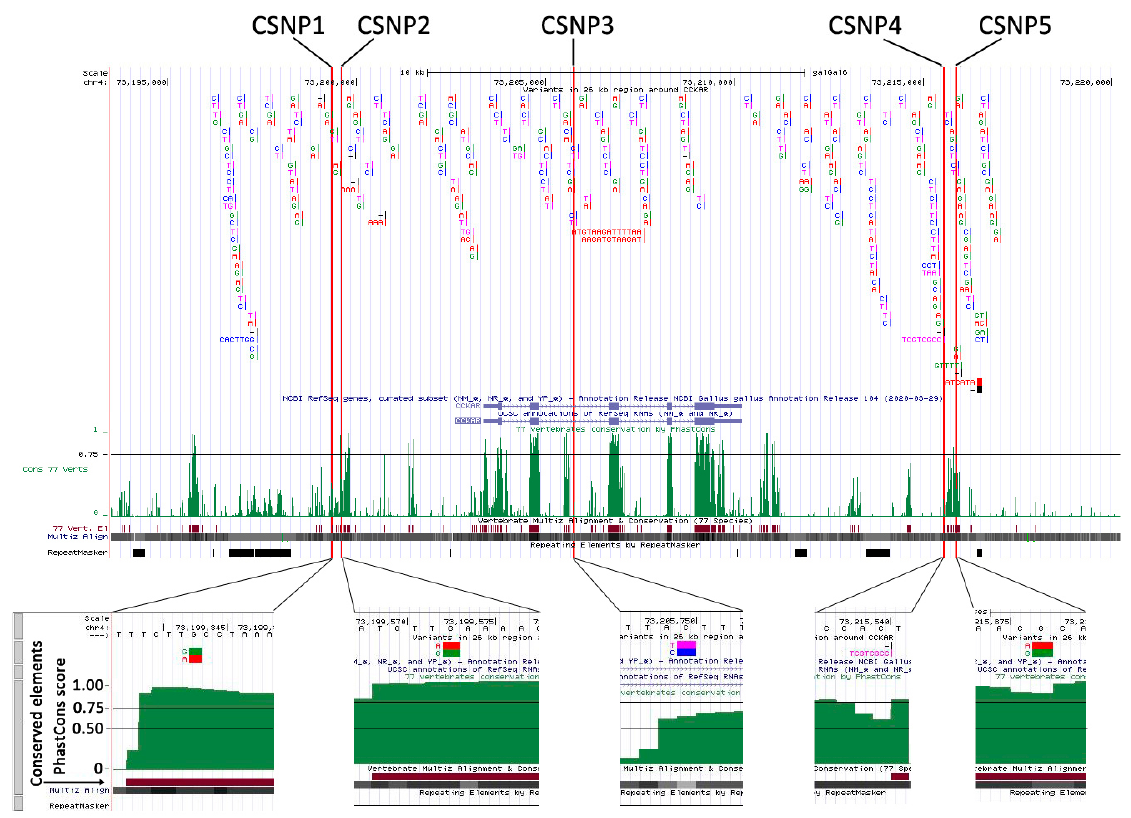
Figure 2. Distribution of sequence variants and results of 76-way vertebrate conservation analysis in the 21 kb region around the CCKAR.